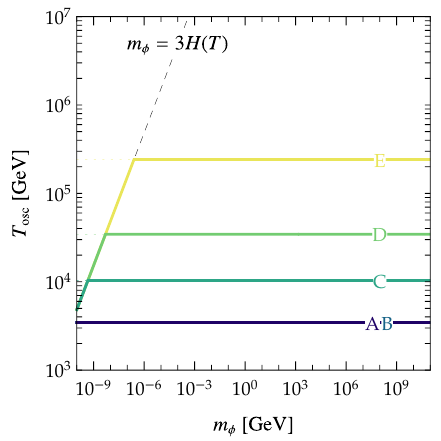
Figure 14 . Temperature at the onset of oscillations for the di(cid:11)erent scenarios. The black line shows the condition m (cid:30) = 3 H ( T ), that determines the initial temperature only at very low